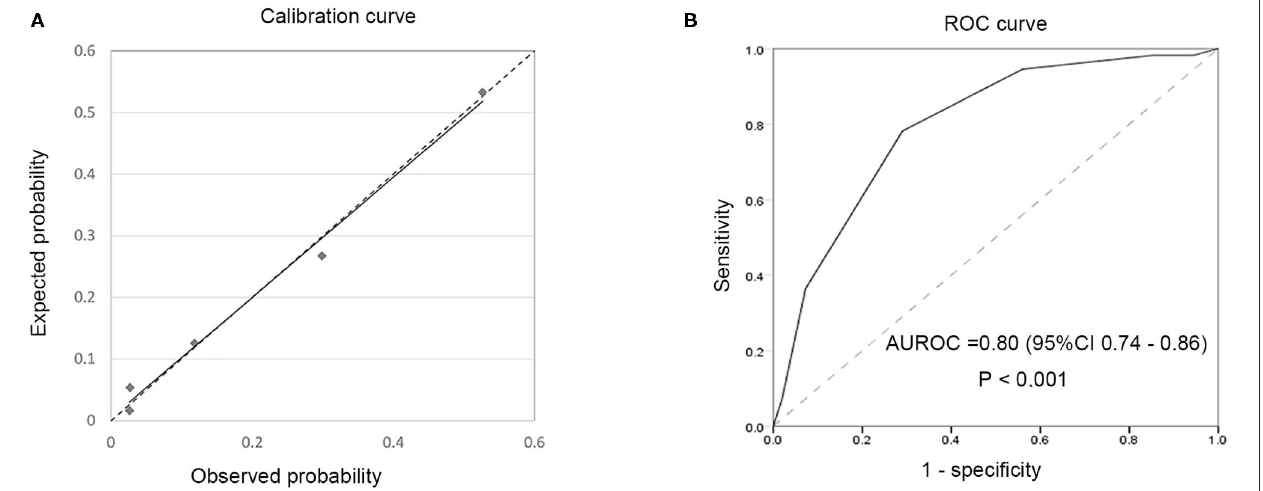
FIGURE 3 | Calibration curve for expected vs. observed probability in the overall cohort (A) and receiver operating curve of risk predicting model in PDAP episodes (B)